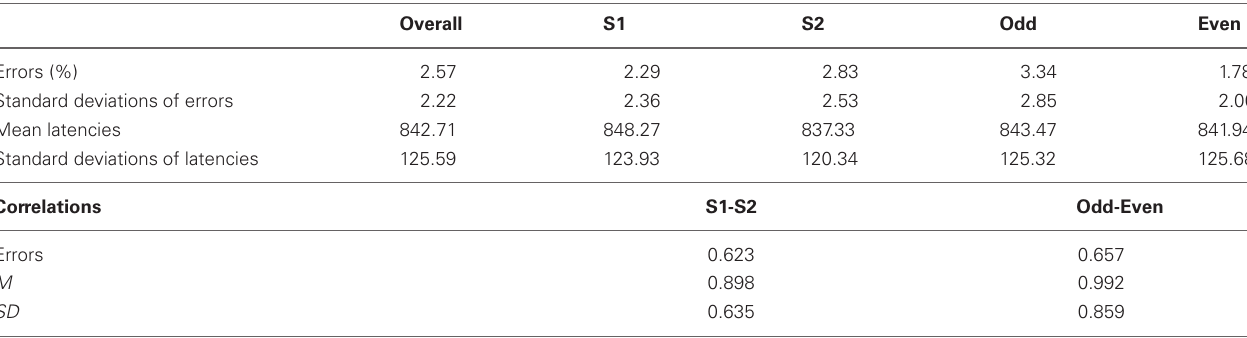
Table 2 | (Upper) Mean percentages of errors, mean latencies and standard deviations (in ms) overall and as a function of sessions and for the odd and even trial within sessions; (Lower) Correlations between session 1 (S1) and session 2 (S2) and between odd and even trials for errors and for the means and standard deviations of the latencies.